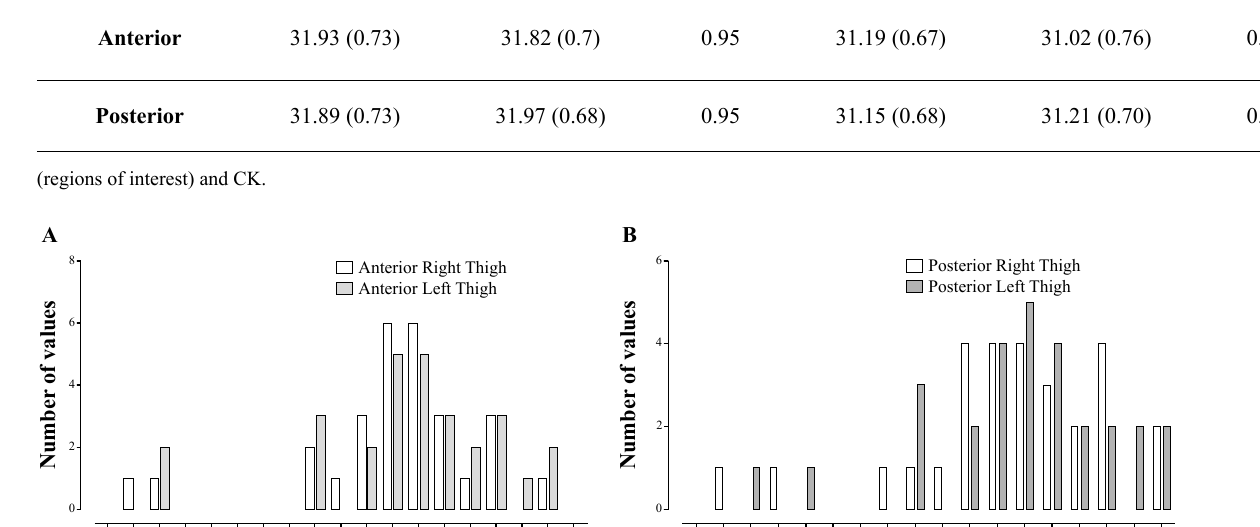
Table 3: Mean values of skin temperature (oC) of thigh and leg soccer players and theirs ICC’s Thigh Leg Right Left IC Right Left IC Anterior 31.93 (0.73)